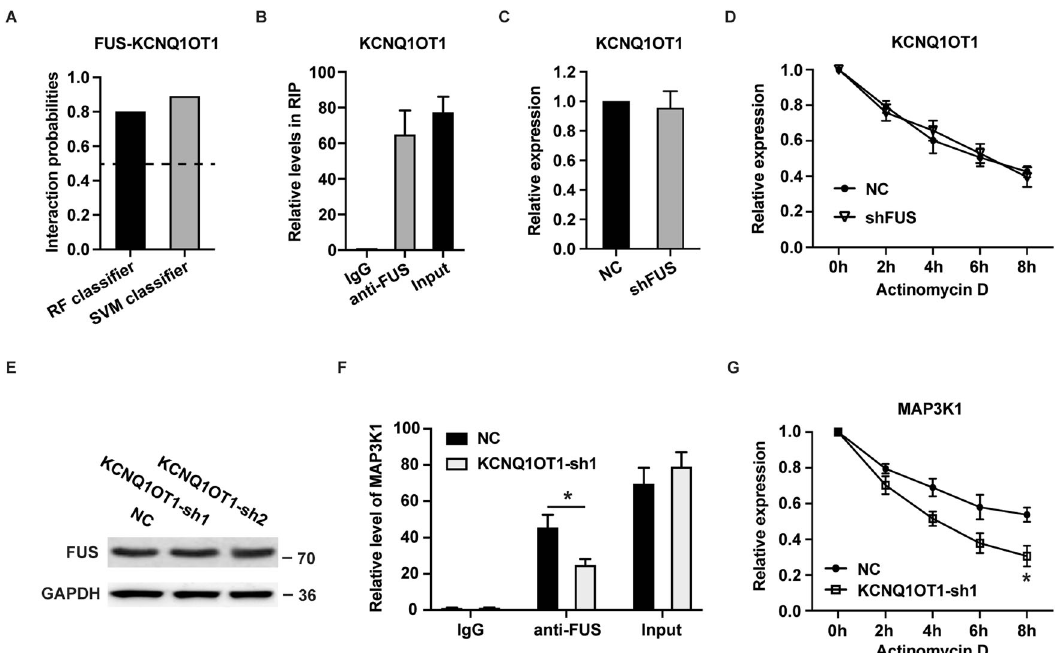
Fig. 5 KCNQ1OT1 and FUS positively regulate MAP3K1 mRNA stability. A The interaction probability between FUS and KCNQ1OT1 was predicted by the RPISeq website. B The fold enrichment of KCNQ1OT1 was analyzed in FUS RIP in NB4 cells. C The expression of KCNQ1OT1 was analyzed in NB4 cells transfected with shFUS. D The expression level of KCNQ1OT1 in NB4 cells infected with shFUS and negative control were analyzed every 2h after treatment with actinomycin D. E Western blot assay was performed to determine the expression level of FUS in NB4 cells infected with KCNQ1OT1-sh1 and KCNQ1OT1-sh2. F The fold enrichment of MAP3K1 was determined in FUS RIP in NB4 cells infected with KCNQ1OT1-sh1 and negative control (NC). G The level of MAP3K1 mRNA in NB4 cells infected with KCNQ1OT1-sh1 and negative control was analyzed every 2h after treatment with actinomycin D. The data are shown with the means±SEM of three independent experiments. * p <